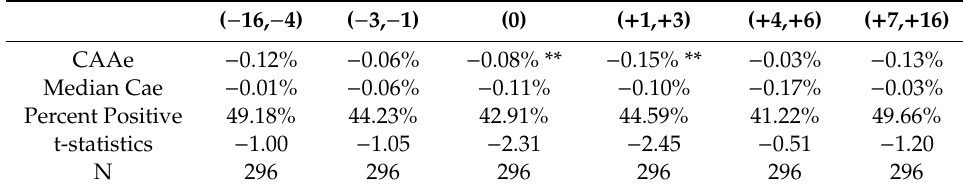
Table 6. The e ff ect of gas discoveries on the real exchange rate for the entire sample of 296 pure announcements with the GARCH